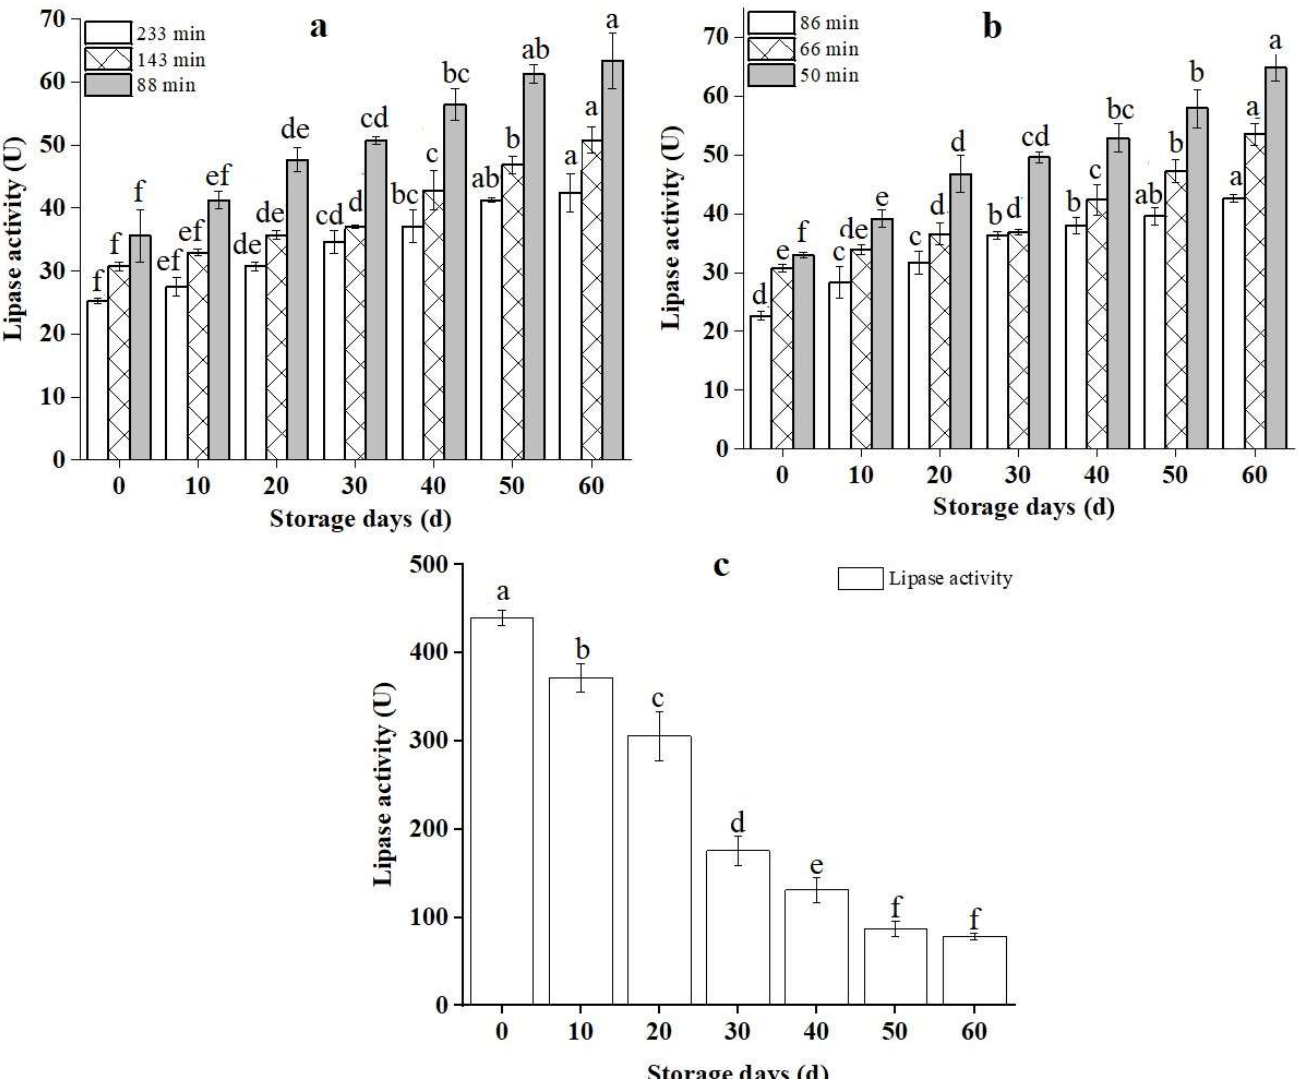
Figure 2. Changes in lipase activity of rice bran after dry heat treatment; ( a , b ) refer to the treatment temperature of rice bran at 120 °C and 130 °C; ( c ) refers to untreated rice bran. Note: The lowercase letters refer to the significant difference of the same sample for different storage periods at the same temperature and treatment conditions at p < 0.05. CNT: Control.